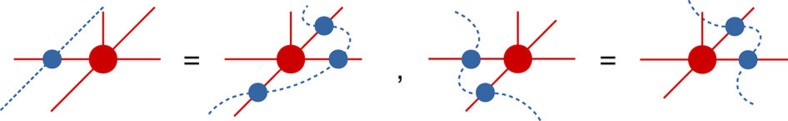
Topological order in PEPS.When representing the state of a quantum lattice system as a PEPS, a local tensor (red) with four virtual indices (which are contracted in the network) and one physical index (pointing upwards) is associated to every site. The PEPS description of topologically ordered states are characterized by the existence of string operators living at the virtual level of the network (acting only on the contracted indices) and that can be pulled through the lattice, such that they are locally invisible. When the string operators are expressed as MPOs, the pulling through yields a local symmetry condition between the PEPS tensor (red) and the MPO tensors (blue), which characterizes the global topological order in the full-quantum state.